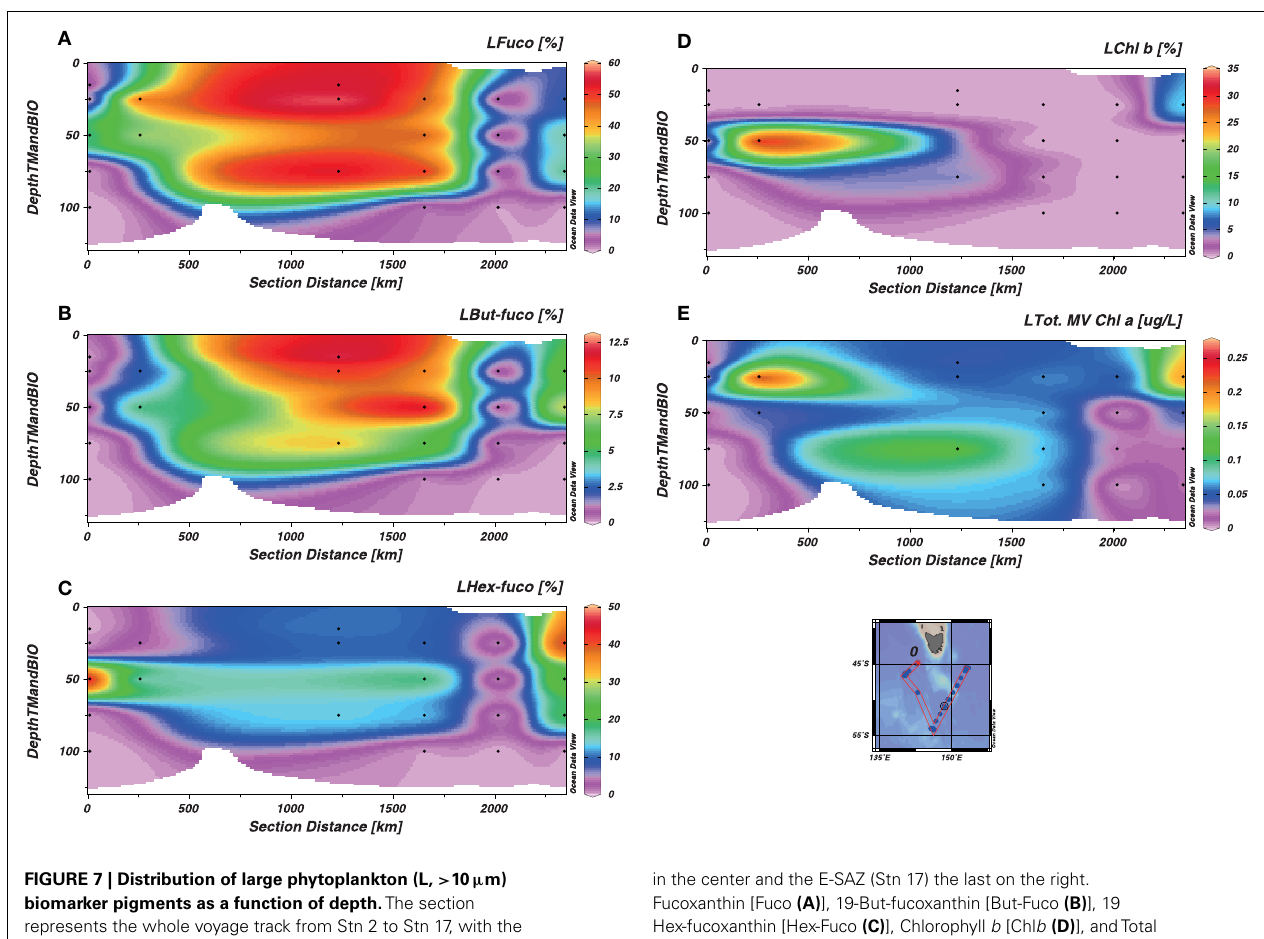
FIGURE 7 | Distribution of large phytoplankton (L, > 10 µ m) biomarker pigments as a function of depth. The section represents the whole voyage track from Stn 2 to Stn 17, with the W-SAZ (Stn 4) being the second station on the left, the PFZ (Stn 6)